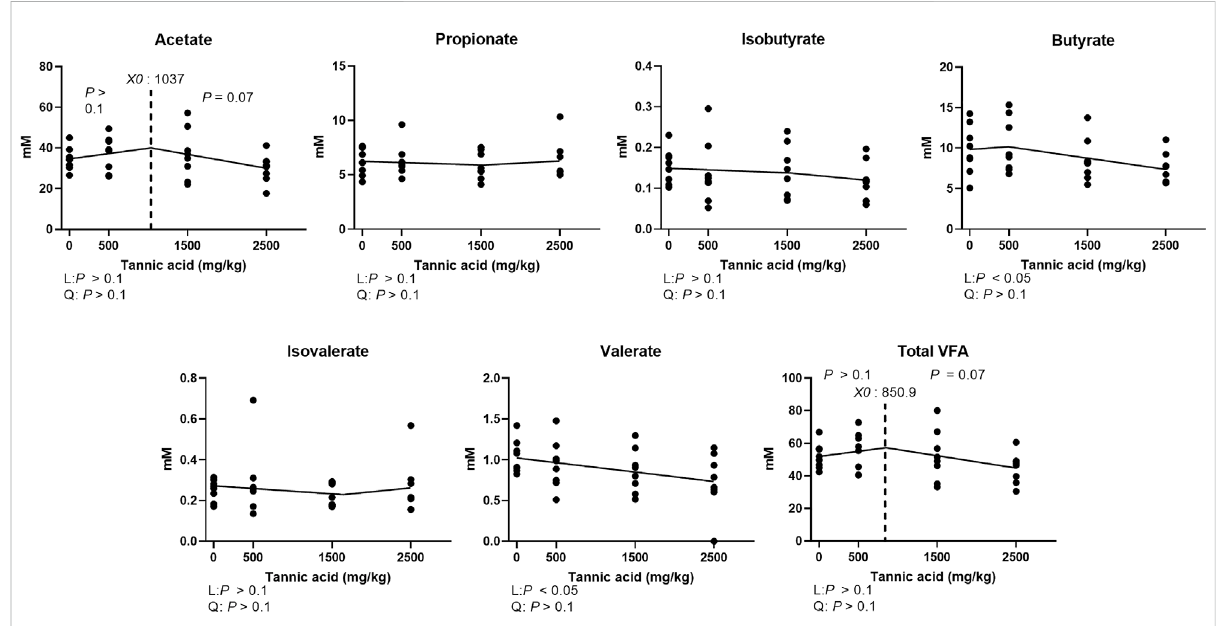
FIGURE 9 Cecal volatile fatty acid concentration (mM) in broiler chickens fed different concentrations (0, 0.5, 1.5, 2.5 g/kg) of tannic acid on D 21. The treatment groups were compared using one-way ANOVA followed by the Tukey ’ s multiple comparison. Different superscripts differ at p < 0.05. Orthogonal polynomial contrasts analysis was conducted to see linear pattern (L) and quadratic pattern (Q) among the treatments. To calculate the optimal dosage of tannic acid in broilers, segmented linear regression was conducted, and X0 (in fl ection point) with p values for slope 1 (lower than X0 ) and slope 2 (higher than X0 ) were